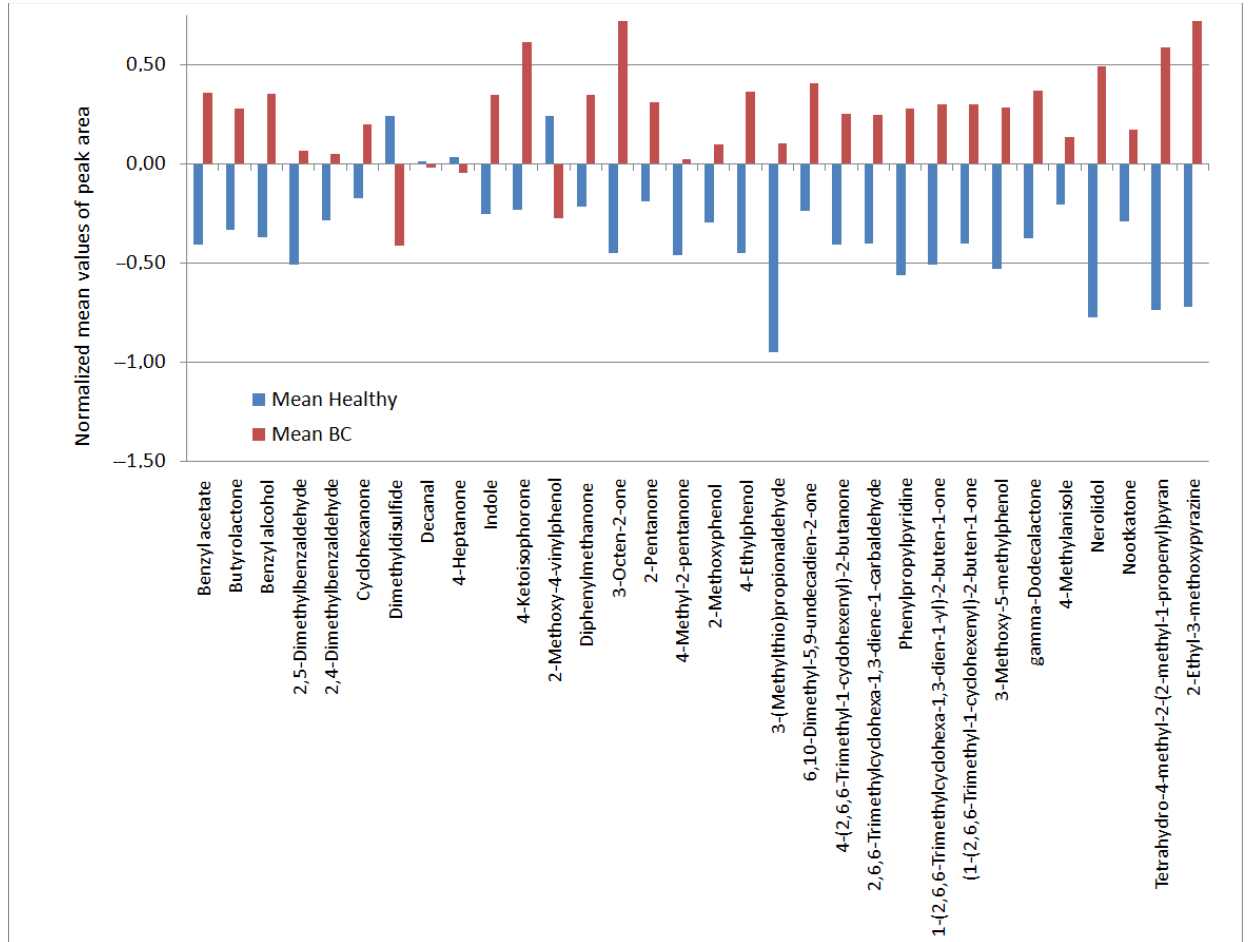
Figure 2. Normalized mean peak areas of compounds for healthy persons (H) and cancer patients(BC). Artificial neural networks (ANN) turned out to be the best method of